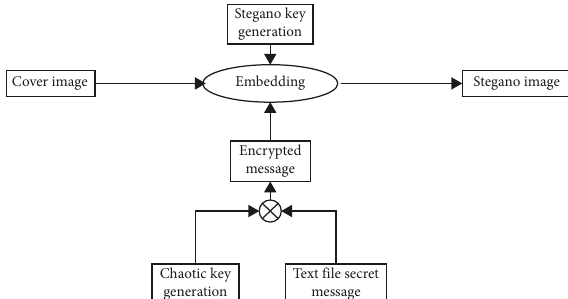
Figure 10: Schematic diagram of the proposed steganography and chaos encryption